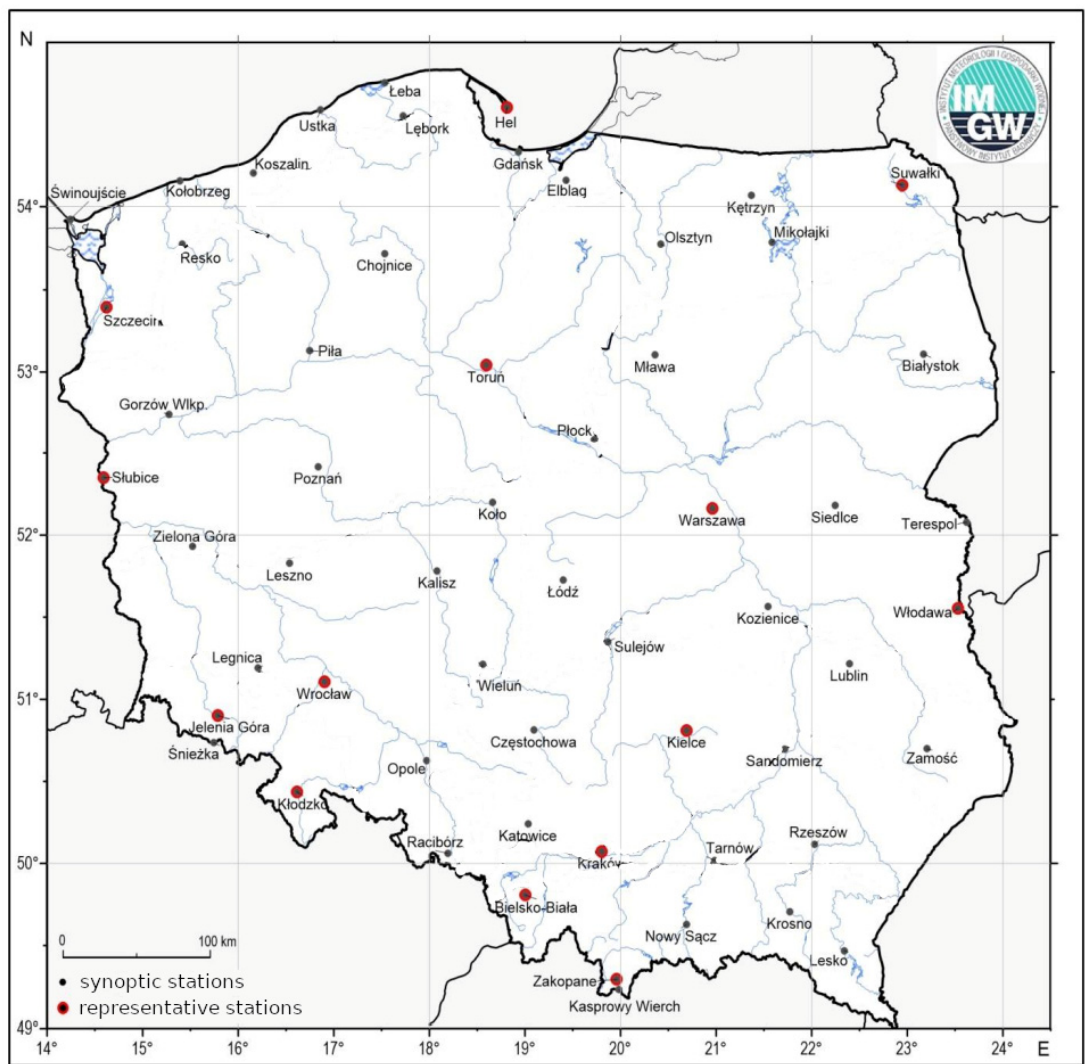
Figure 1. Location of synoptic and synoptic representative stations in Poland.